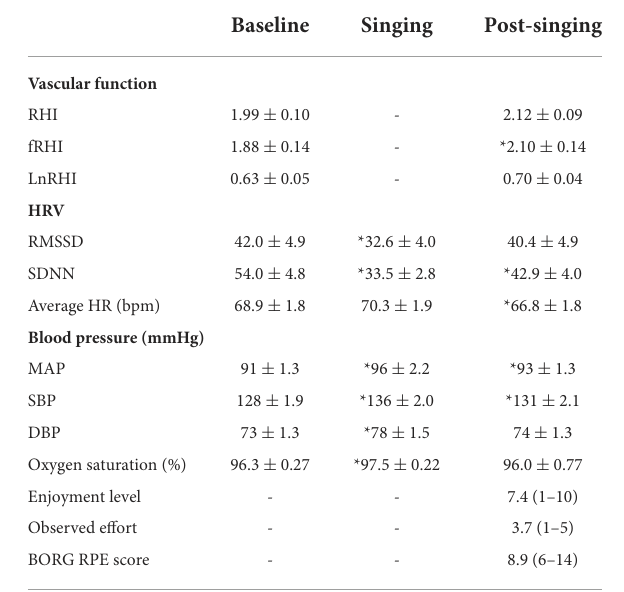
TABLE 2 Results ( n = 60).